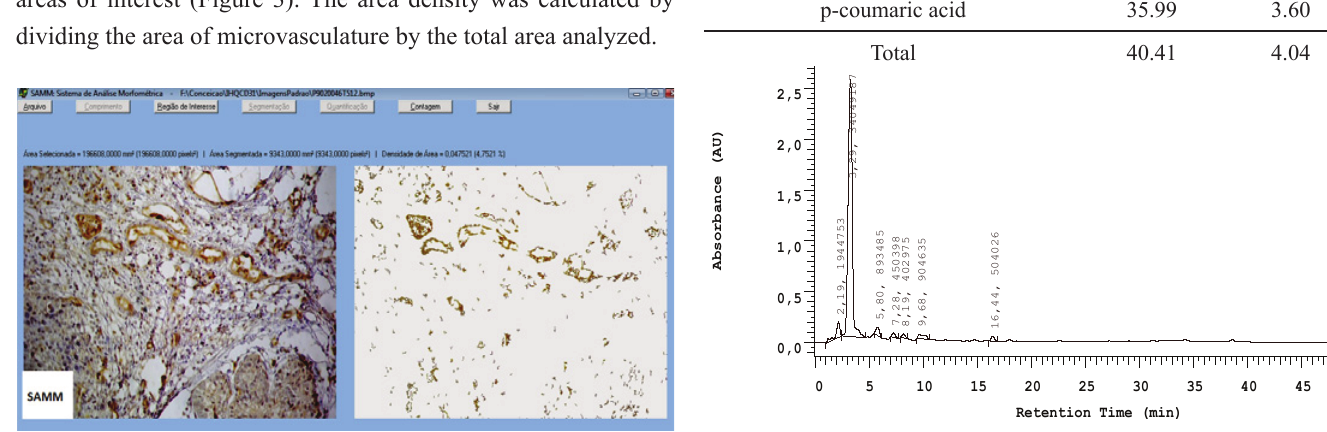
FIGURE 4 - High Performance (pressure) Liquid Chromatography